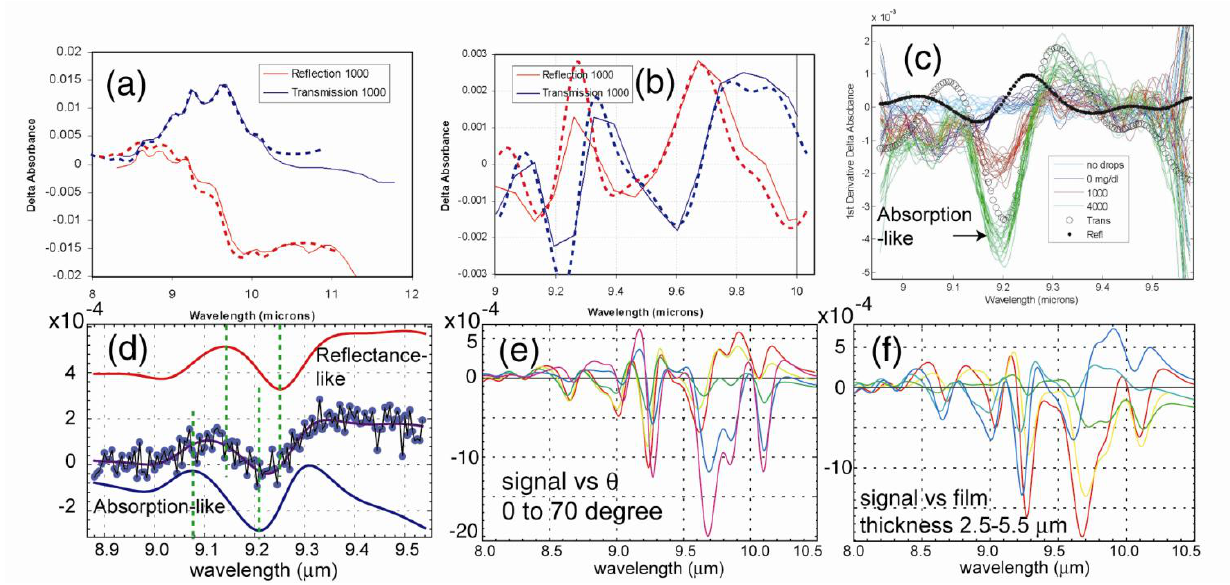
Figure 13. Spectra of aqueous glucose from Refs. [30,31] (a) Reflectance spectrum from gelatin glucose and transmission spectrum of aqueous glucose with modeling (dashed line) (b) Derivative vs. wavenumber of the spectra in (a); solid lines are experiments, dashed lines are modeling results. (c) and (d): Derivative spectra of diffuse backscattered signal of aqueous glucose thin film under the experimental configuration in Figure 11(b). In (c), the glucose is in a thin tear layer on a human eye conjunctiva, showing absorption-like result. But (d) is a different result that is neither reflectance-like nor absorption-like, it is fitted with a computer simulation (solid curve fit). (e) and (f): exact calculation of signal in Equation (10), showing significant spectrum variation vs. incident angle and film